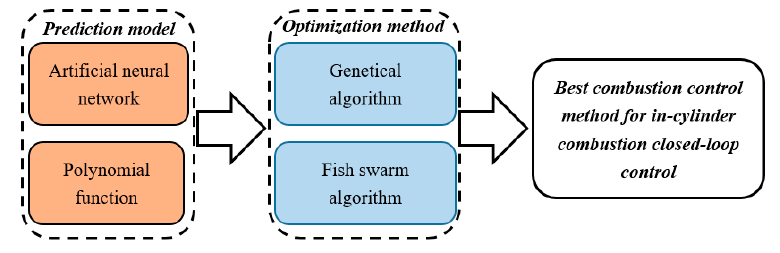
Figure 1. Structure of this paper.